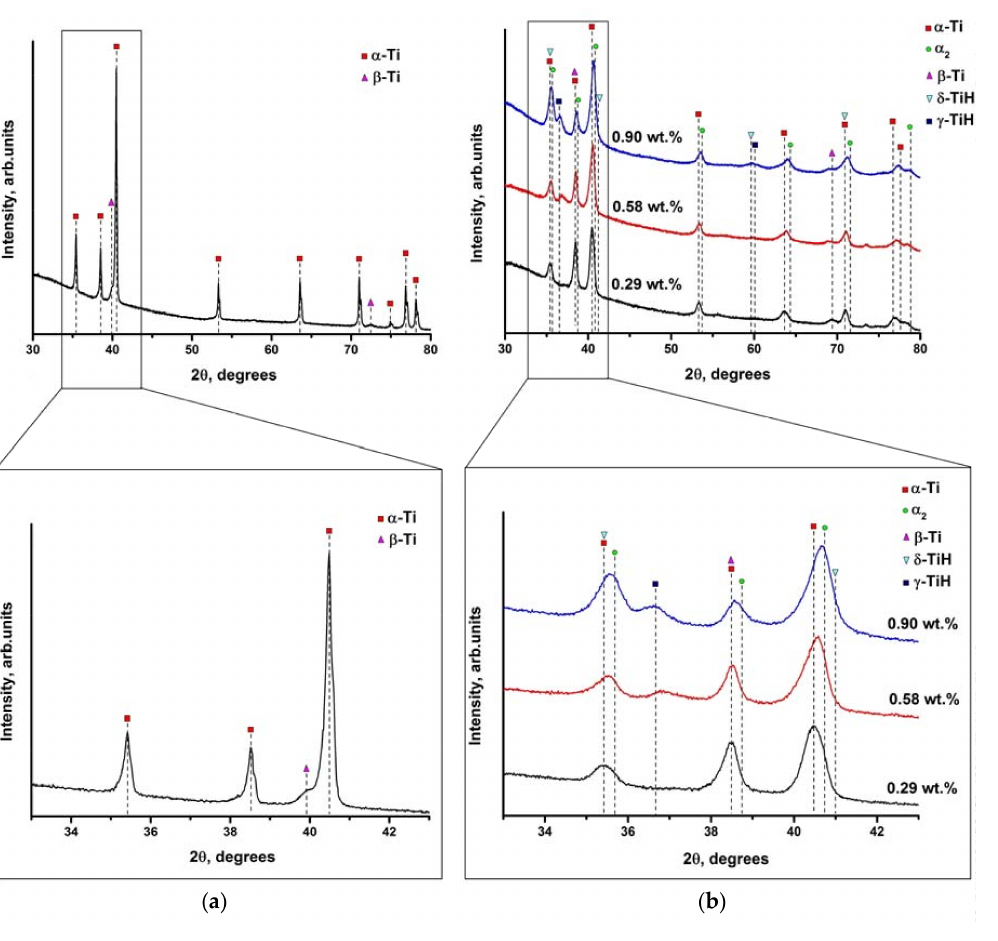
Figure 1. X-ray diffraction (XRD) patterns of Ti-6Al-4V parts produced by electron beam melting (EBM) before ( a ) and after ( b ) gas-phase